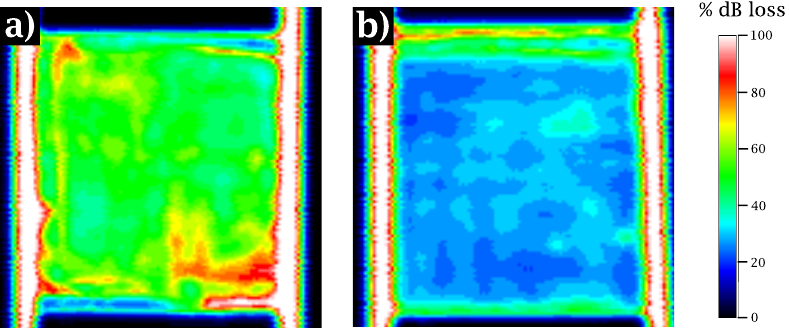
Figure 13. C-Scan inspections for ( a ) Laminates with 0-CFs ( Lam 0 ), and ( b ) Laminates with I-CFs ( Lam I ). The color bar indicates wave intensity